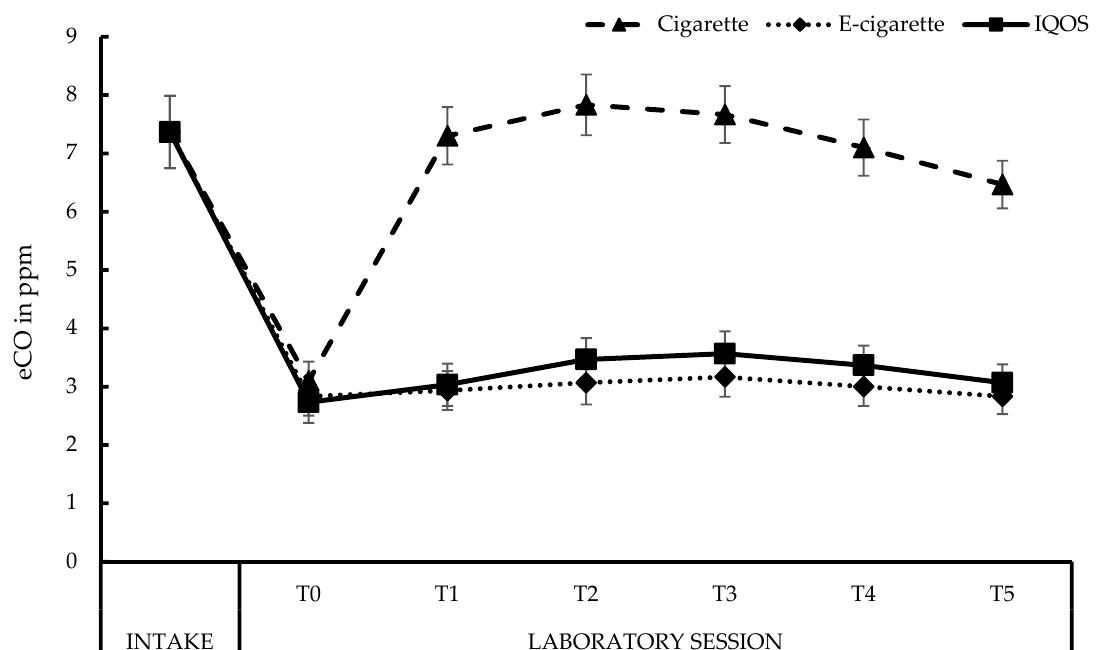
Figure 2. Exhaled CO (eCO) levels in ppm. Cigarette : M Intake ( SE between brackets) = 7.37 (0.62), M T0 = 3.10 (0.33), M T1 = 7.30 (0.49), M T2 = 7.83 (0.52), M T3 = 7.67 (0.49), M T4 = 7.10 (0.48), M T5 = 6.47 (0.41); E-cigarette : M Intake = 7.37 (0.62), M T0 = 2.83 (0.33), M T1 = 2.93 (0.33), M T2 = 3.07 (0.37), M T3 = 3.17 (0.34), M T4 = 3.00 (0.33), M T5 = 2.83 (0.30); IQOS TM : M Intake = 7.37 (0.62), M T0 = 2.73 (0.35), M T1 = 3.03 (0.36), M T2 = 3.47 (0.36), M T3 = 3.57 (0.38), M T4 = 3.37 (0.34), M T5 = 3.07 (0.32).